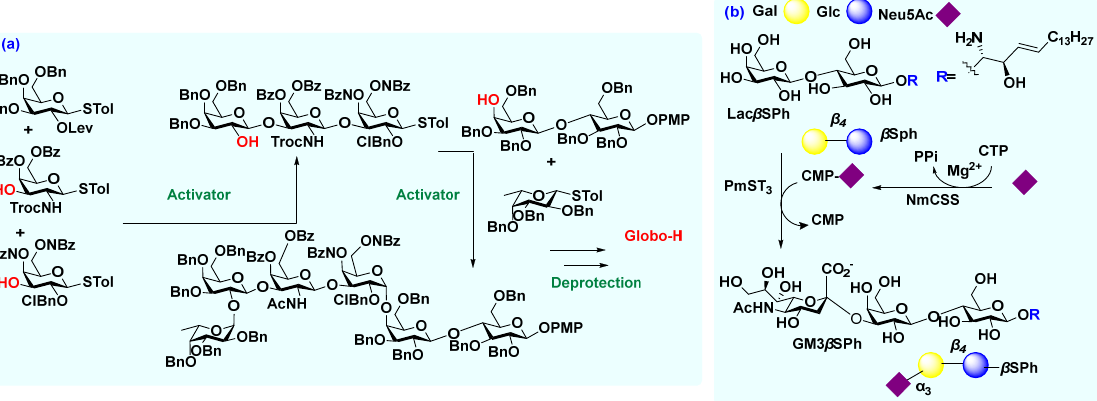
Figure 3. Synthesis of tumor antigens: ( a ) synthesis of Globo-H via glycosylation; ( b ) chemoenzymatic synthesis of GM3 β SPh. Abbreviation: see Section 2.1.2 & 2.1.2.